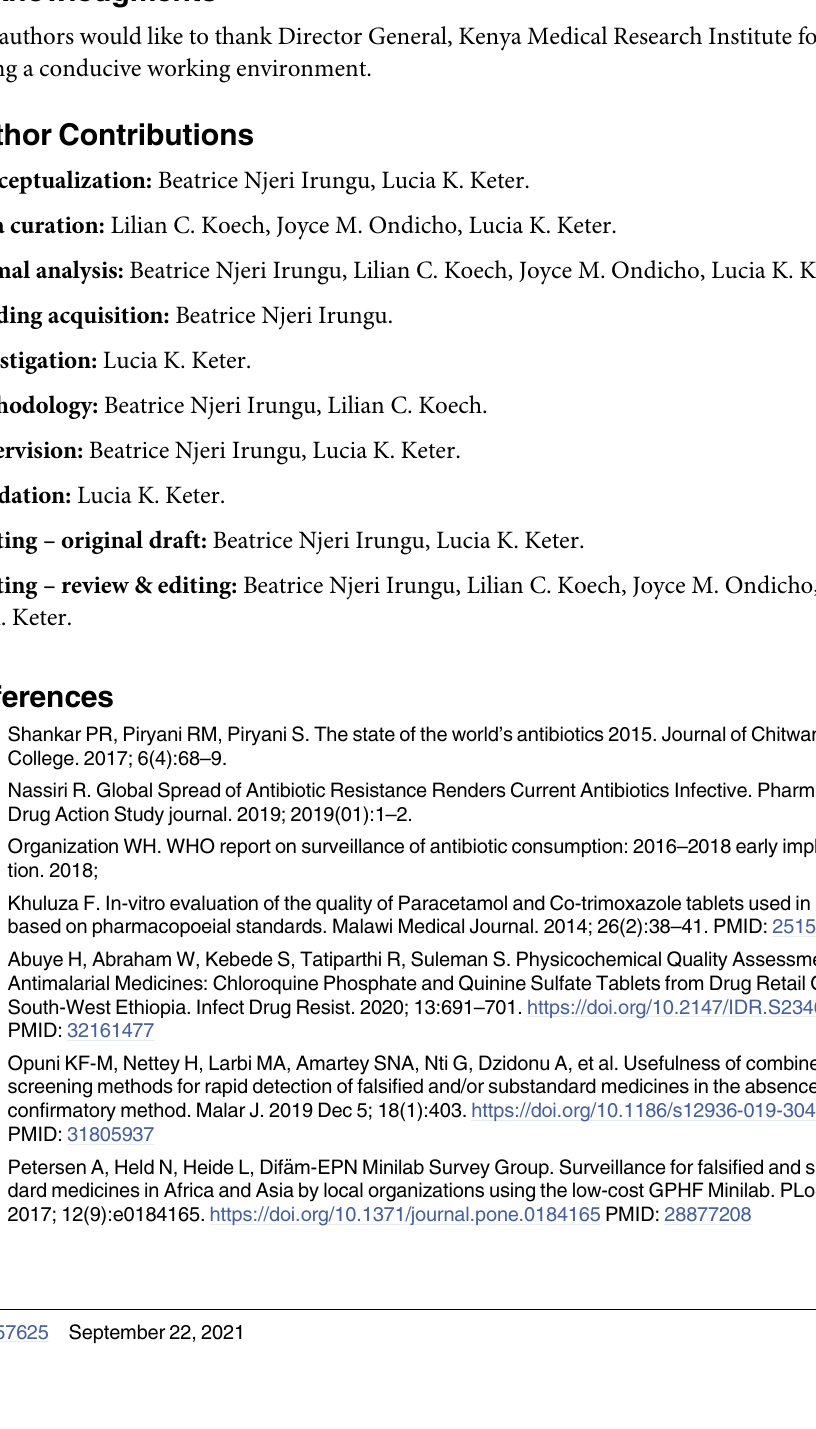
S1 Table. Distribution of API non-compliant samples in both lower and upper